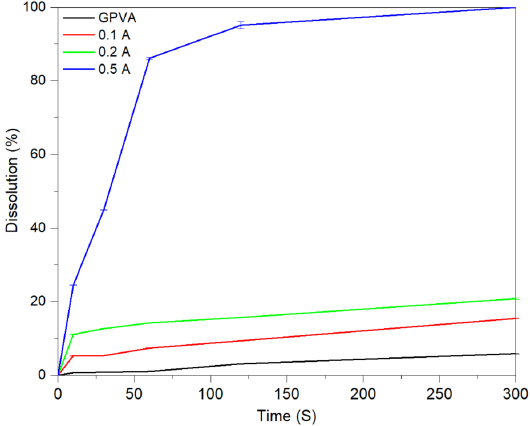
Figure 2. Time-dependence dissolution of